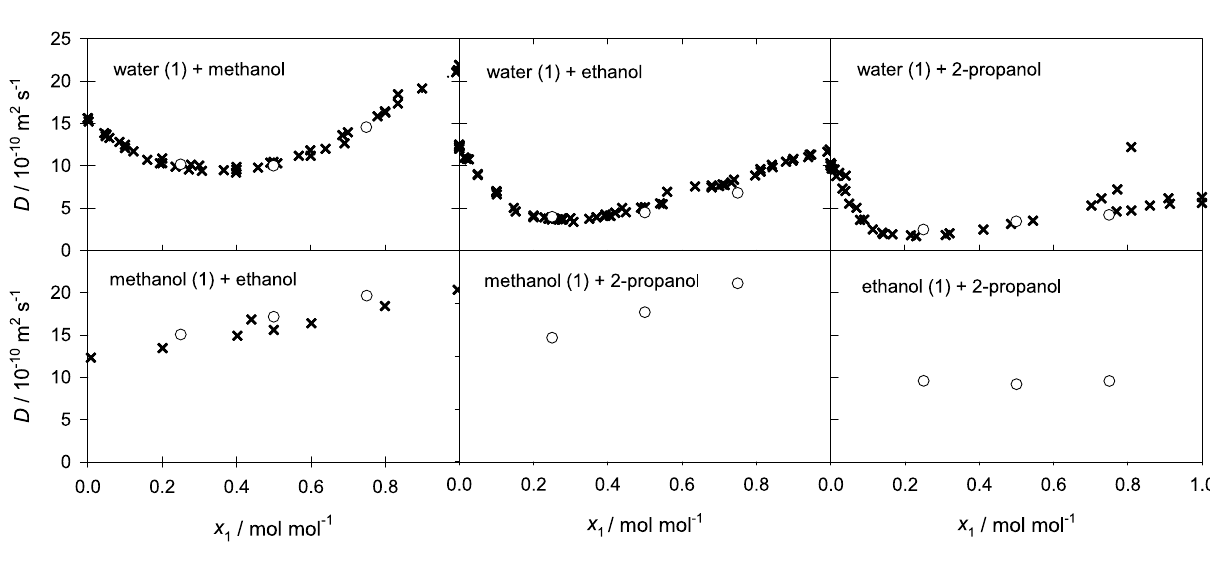
Figure 7. Fick diffusion coefficient of the six binary subsystems at 298.15 K and 0.1 MPa. Present simulation results (circles) are compared with experimental literature data 21,40–48 (crosses). The error bars are within symbol